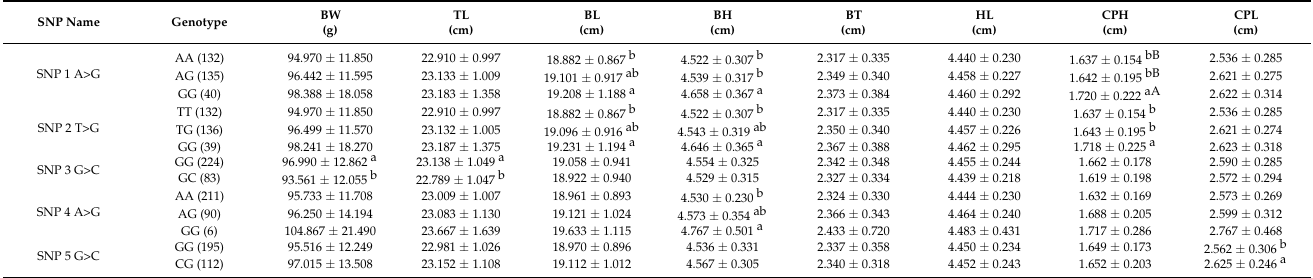
Table 3. Association analysis of five SNP loci and growth traits in striped catfish. Note: The data are presented as mean ± SD. For each growth trait of the same SNP locus, different lowercase letters indicate significant differences ( p < 0.05) and different capital letters indicate extremely significant differences ( p < 0.01).